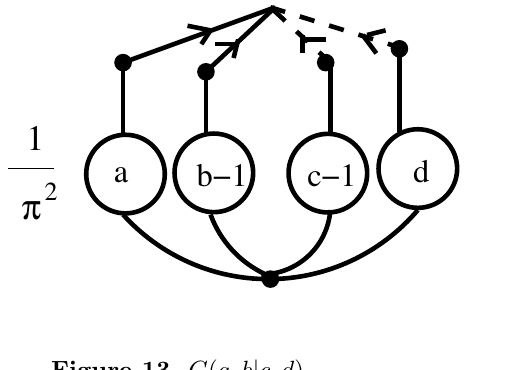
Figure 13 . G ( a; b j c; d